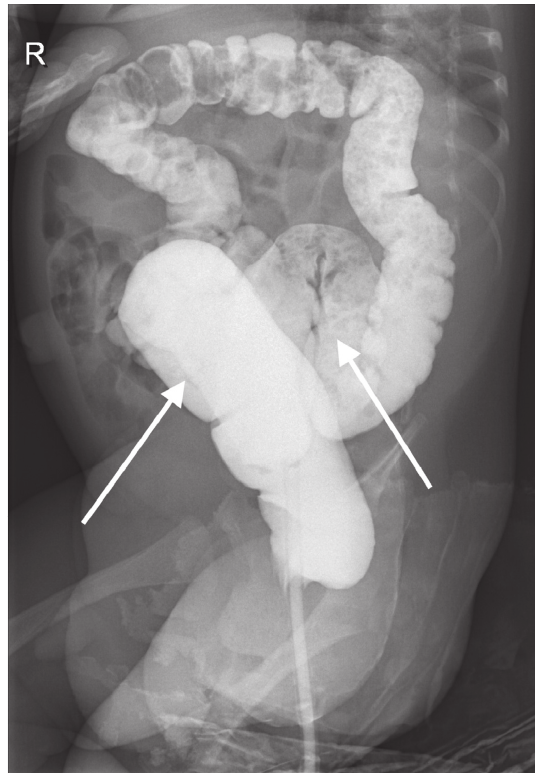
Figure 2: Barium enema X-ray. Dolichocolon (additional curves at sigmoid and transverse colon, arrows), no strictures, no pathological bowel dilatations, and no signs of Hirschsprung’s